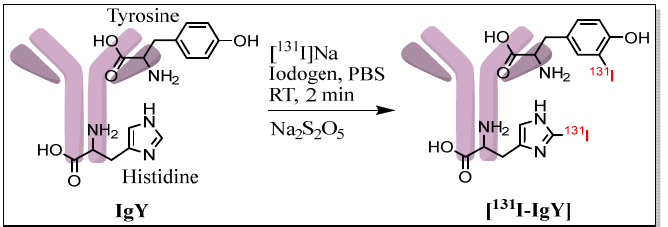
Figure 3. Schematic of direct radioiodination of IgY with iodine-131.